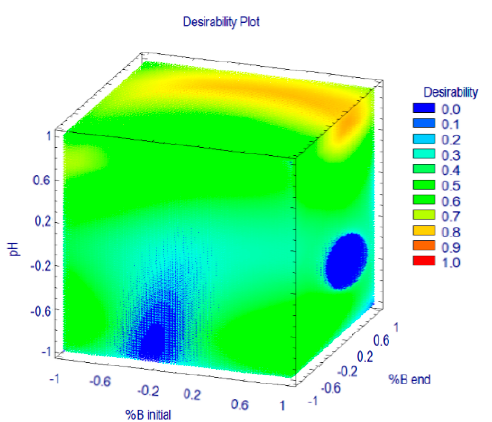
Figure 2. 3D contour plot showing interactive effects of % B start ( x 1 ), % B end ( x 2 ), and pH ( x 3 ) over desirability for the HPLC-DAD method.